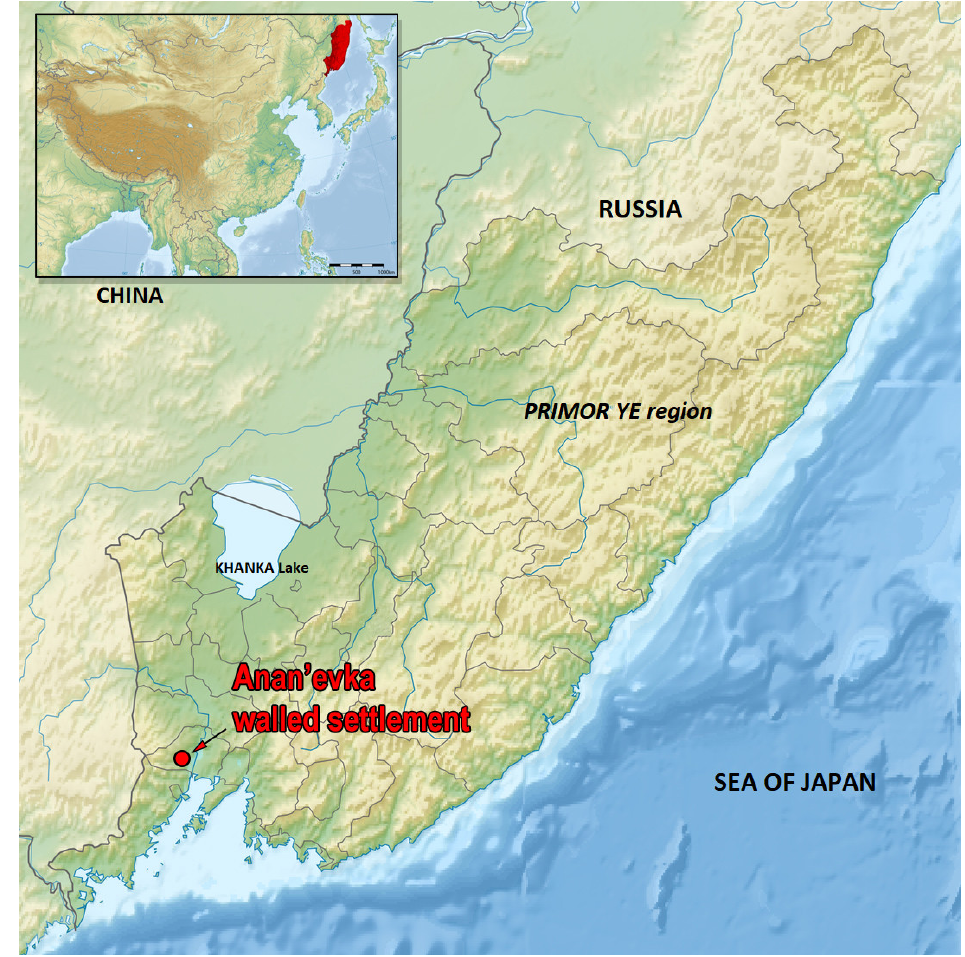
Figure 1. The Anan’evka walled settlement location in the territory of the Primor’ye region. Colors of the figurine’s polychrome decoration are red, green, black, and yellow on a white background. This color range has no close similarities among known